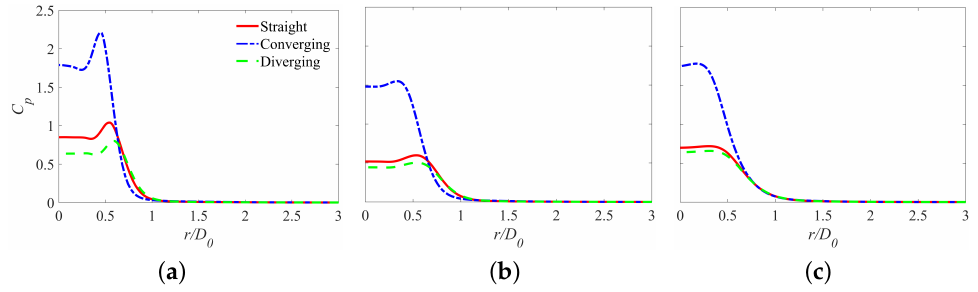
Figure 19. Pressure coefficient C p on the target surface at ( a ) H = 0.5, ( b ) H = 2, and ( c ) H = 4.